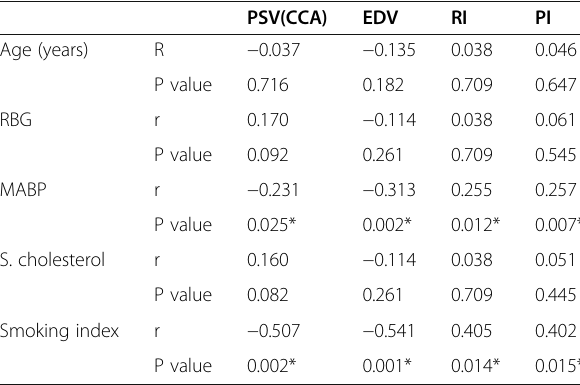
Table 1 The correlations of risk factors of stroke with duplex parameters of CCA in studied patients